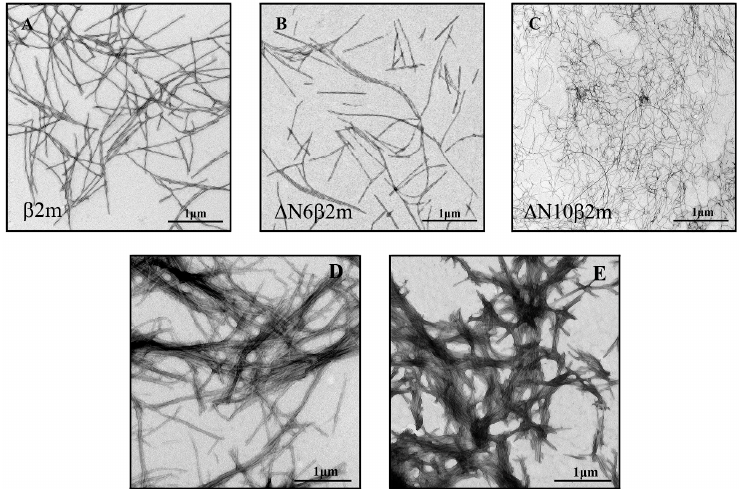
Figure 1. Electron micrographs of the amyloid fibrils formed from ( A ) beta ‐ 2 ‐ microglobulin ( β 2m), ∆ N6 β 2m, ( C ) ∆ N10 β 2m, ( D ) insulin, and ( E ) lysozyme. Scale bar is 1 µ ( B )  N6 β 2m, ( C )  N10 β 2m, ( D ) insulin, and ( E ) lysozyme. Scale bar is 1 μ m. ( B )